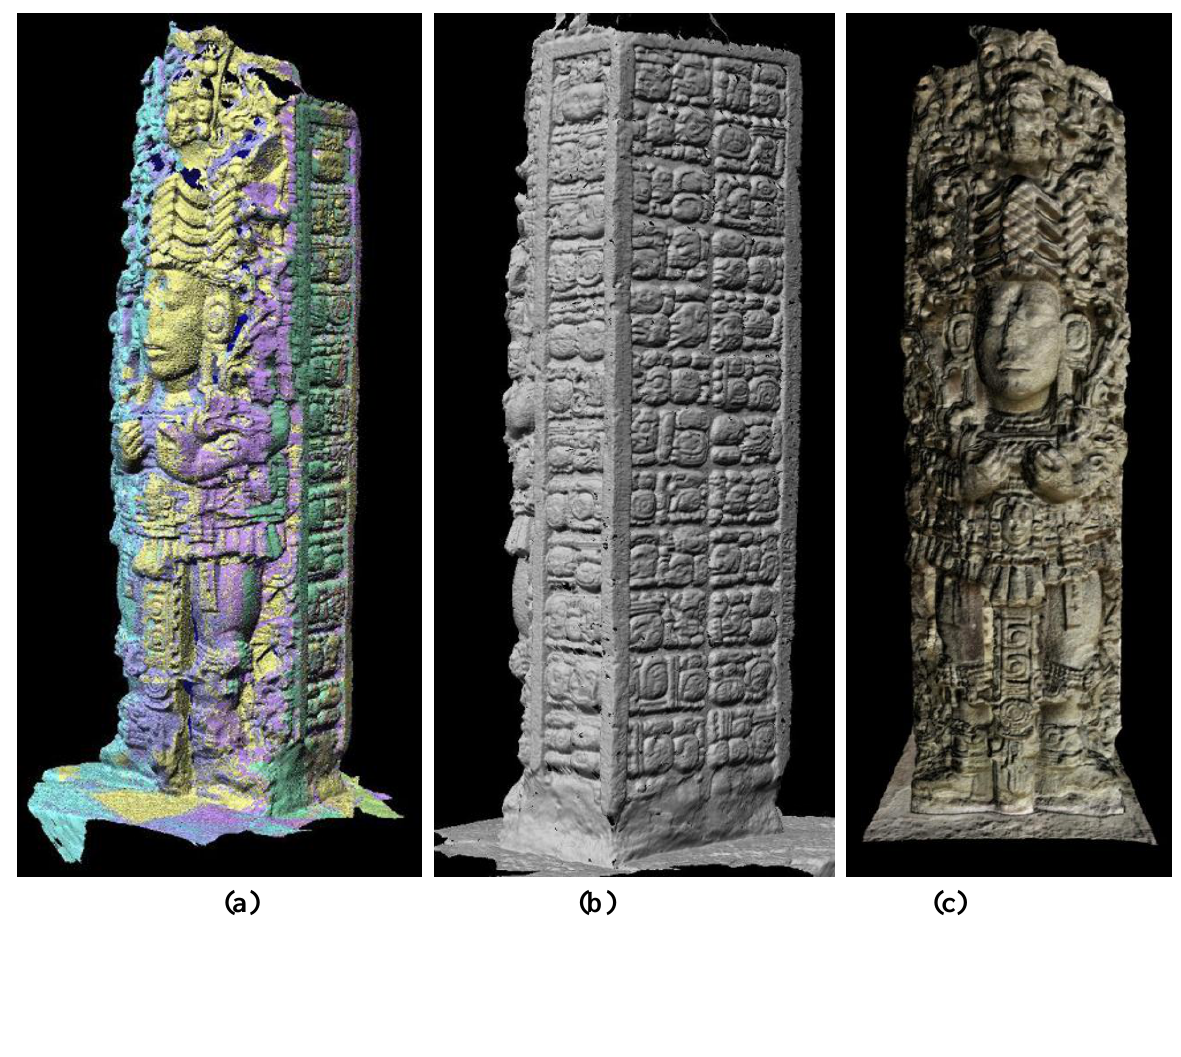
Figure 10. Different point clouds, acquired with a TOF laser scanner, are aligned (a) , converted into a polygonal mesh (b) and textured (c) for photo-realistic